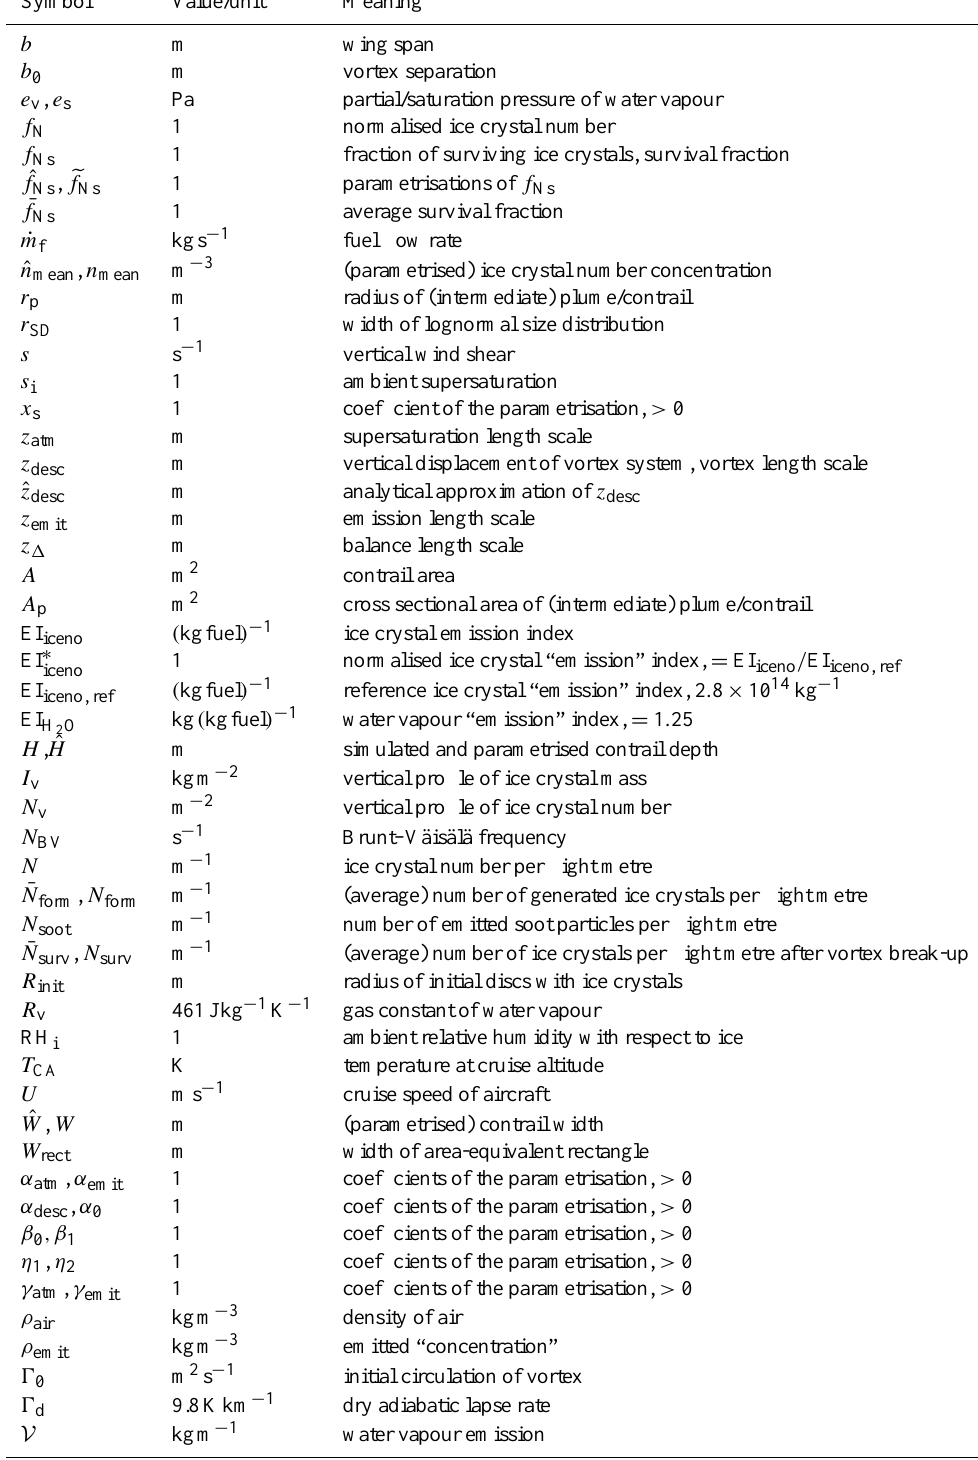
Table A1. List of